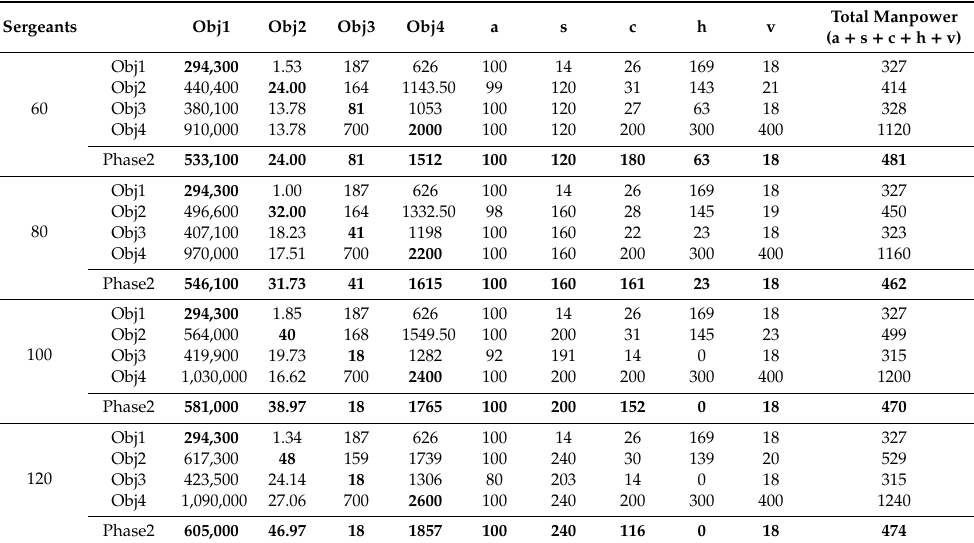
Table A3. Sensitivity of optimal scheduling with increasing number of